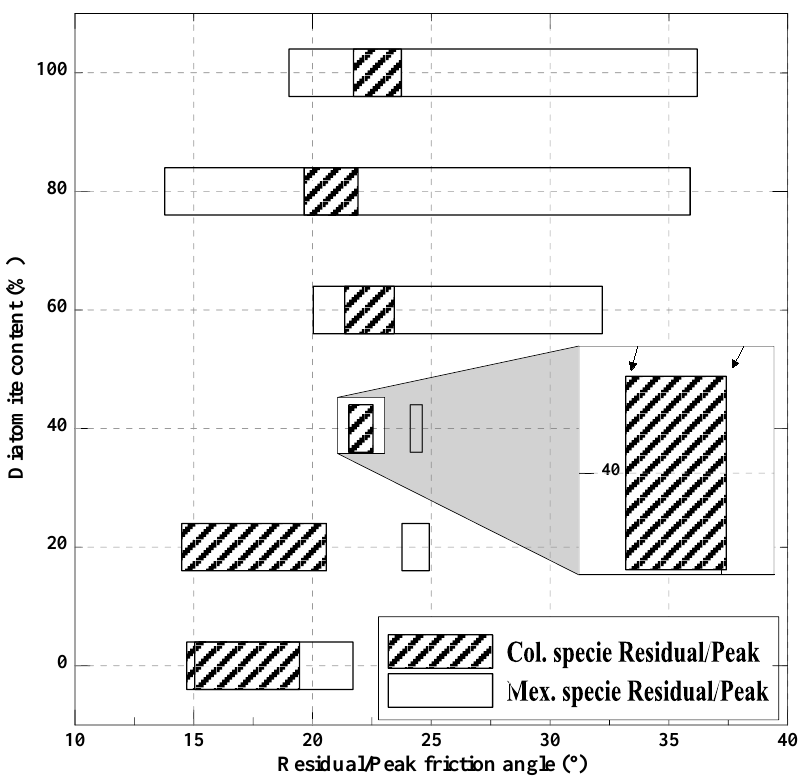
From the normal shear stress plots, the peak and the residual friction angles, which are indicators of the effect interlocking between particles and the variation of the friction angle, were calculated for all kaolin-diatomite specimens (see Figure 9). The cohesion for both peak and residual states was nulled in view of the contractive volumetric response, typical for normally consolidated materials. Concerning Colombian diatomite contents, the variation of the friction angle was almost negligible. In fact, as the diatomite content increased, the gap between peak and friction angles became smaller. This result suggests that this diatomite leads to an increase in the residual friction angle at a higher rate than the friction angle. On the other hand, the variation of the friction angle was higher as the Mexican diatomite content increased. Although the addition of Mexican diatomite may increase both peak and residual friction angles, the growth rate is greater for the peak Figure 8. Relationship between residual shear stress vs. normal stress at different diatom contents. rather than the residual one.